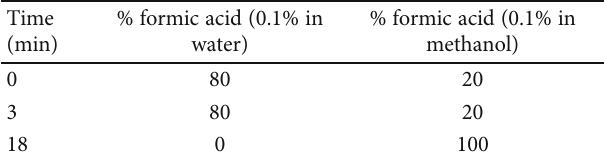
Table 1: Elution